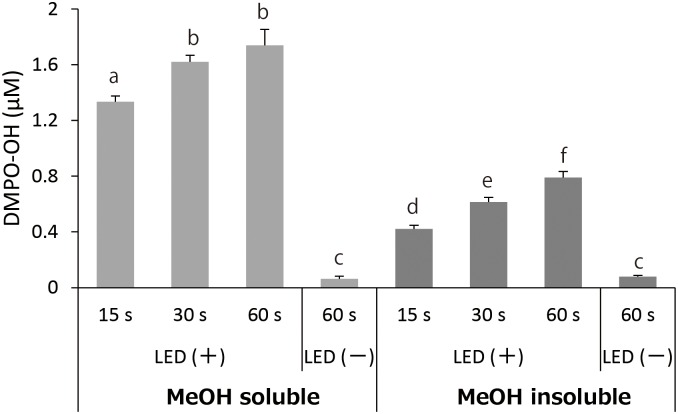
Effect of photo-irradiation time on the yield of •OH (expressed as DMPO-OH) in MeOH soluble and insoluble fractions.Each value represents the mean with standard deviation (n = 3). Significant differences (p<0.05) are denoted by different alphabetical letters. LED(-): Kept under a light shielding condition.